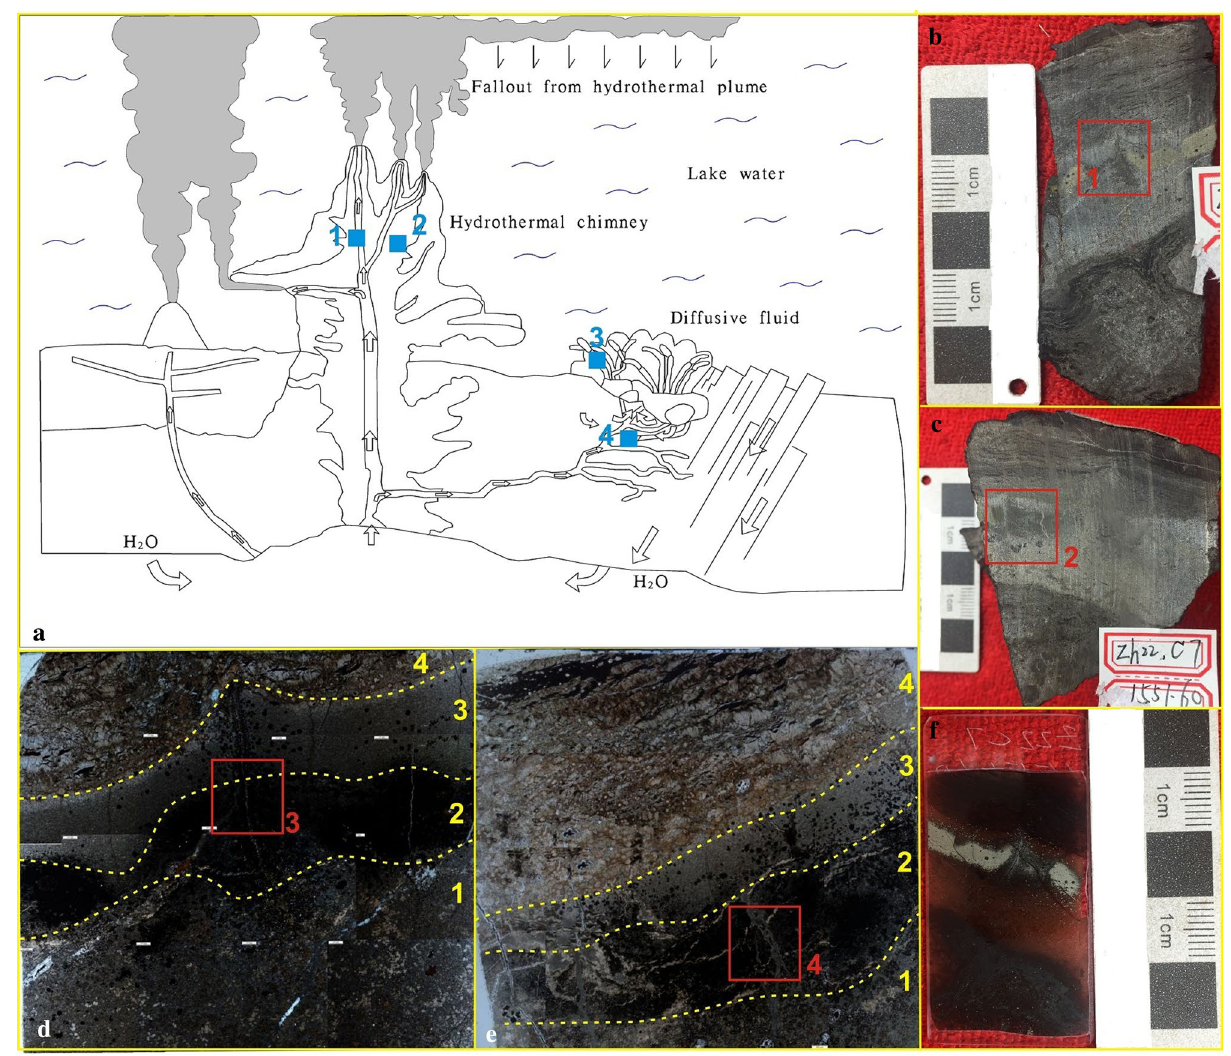
Figure 2. Characteristics of hydrothermal chimneys in the study area (All photos in Fig. 2 were taken by You Jiyuan). ( a ) Sketch of typical hydrothermal chimney (Map modified from reference 1 , (The Figure is drawn with Mapgis 6.7, version number is 6.7, the map from URL link: https:// www. tandf online. com/ doi/ full/ 10. 1080/ 08120 099. 2019. 16127 83). ( b ) Hydrothermal chimney, 6 cm × 4 cm, sample No. 1551.6, the sample was taken from the blue box No. 1 in ( a ); ( c ) Hydrothermal chimney, 7 cm × 6 cm, sample No. 1551.6–2, the sample was taken from the blue box No. 4 in ( a ); ( d ) Enlarged view of the No. 1 red frame in panel b, in which layer 1 is dolomite with a radial structure, layer 2 is pyrite, layer 3 is a dolomite + calcite layer, and layer 4 is calcite + dolomite + anhydrite + animal microfossils. 2.5X magnification, with cross-polarized light. ( e ) Enlarged view of the No. 2 red frame in panel ( c ), in which layer 1 is calcite + dolomite + anhydrite with a radial structure, layer 2 is pyrite, layer 3 is a dolomite + anhydrite layer, layer 4 is calcite + dolomite + anhydrite + animal microfossils. at 2.5X magnification, with cross-polarized light. ( f ) Thin slices of hydrothermal channel